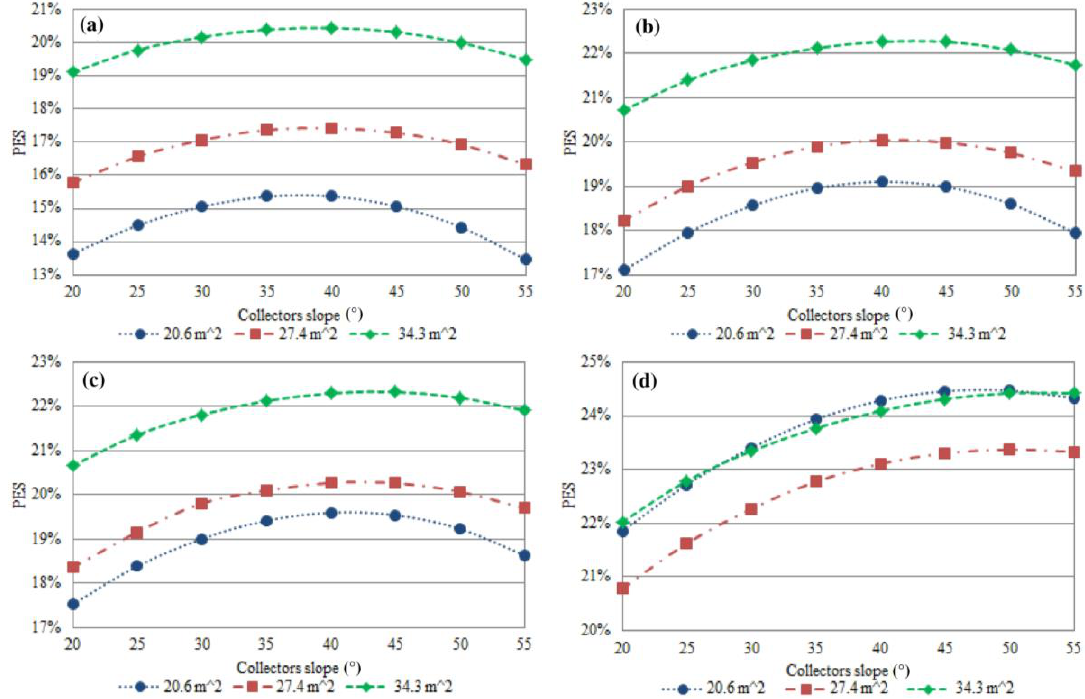
Figure 9. Primary energy saving of the ASs with 0% of solar thermal energy surplus used and evacuated tube collectors in the four alternative configurations: ( a ) Scenario A; ( b ) Scenario B; ( c ) Scenario C; and ( d ) Scenario D.